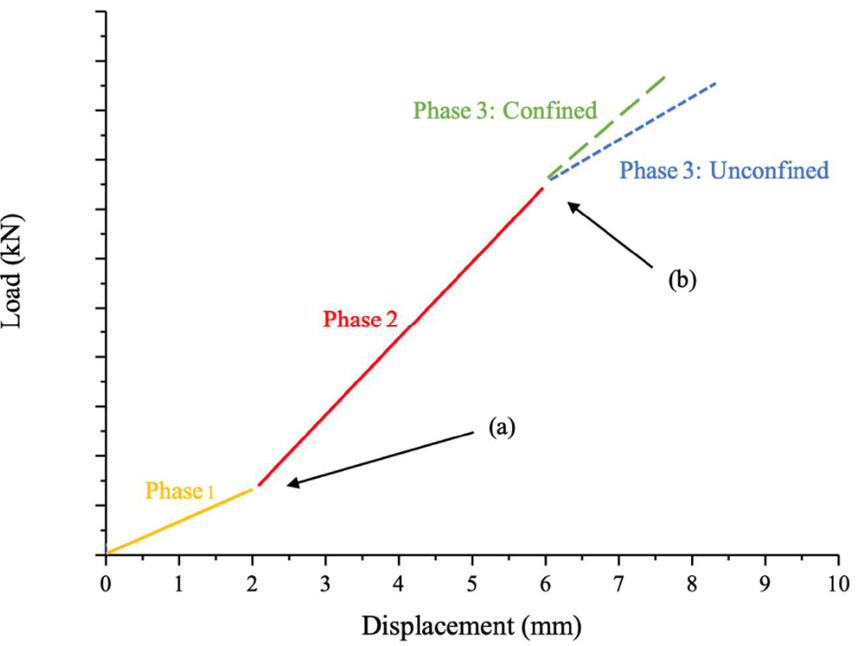
Figure 15. Unconfined Simulation and Experimental Results Comparison. Figure 16. Unconfined Simulation and Experimental Results Comparison.